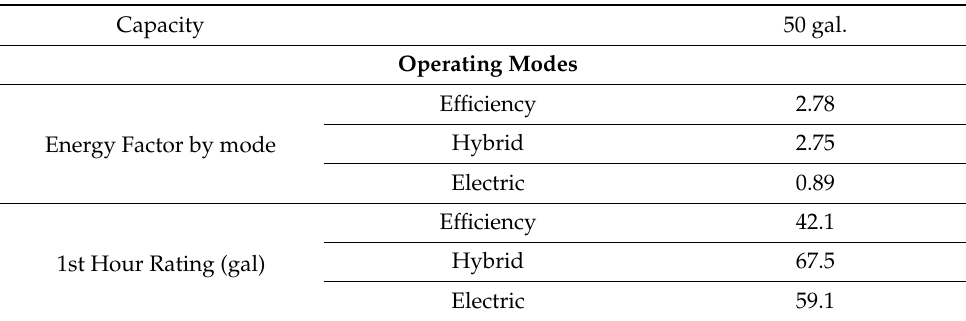
Table 3. Water heater